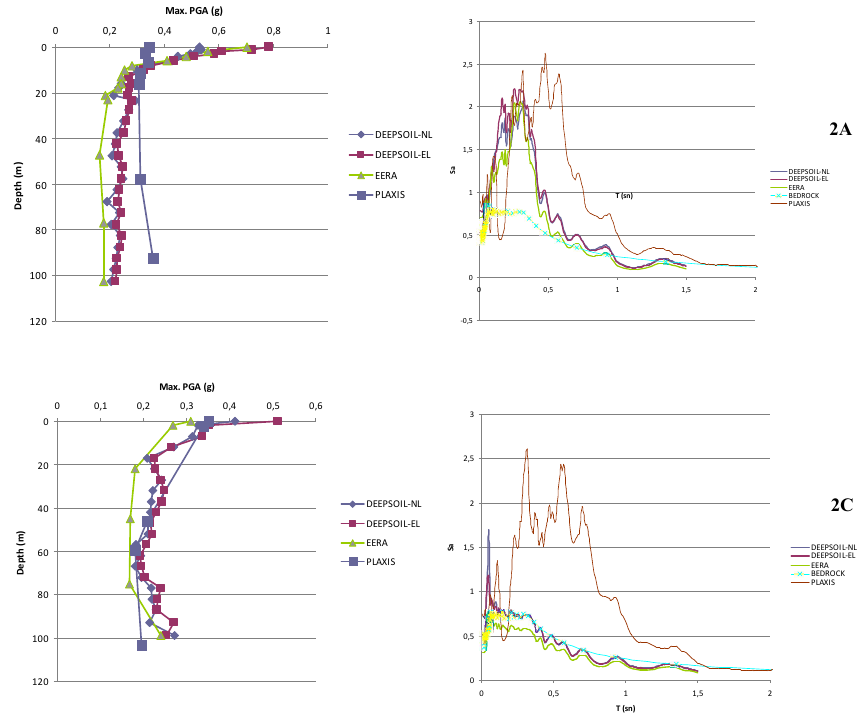
Figure 16. 2-2 0 section; maximum acceleration depth and spectral acceleration period graph for the selected points.